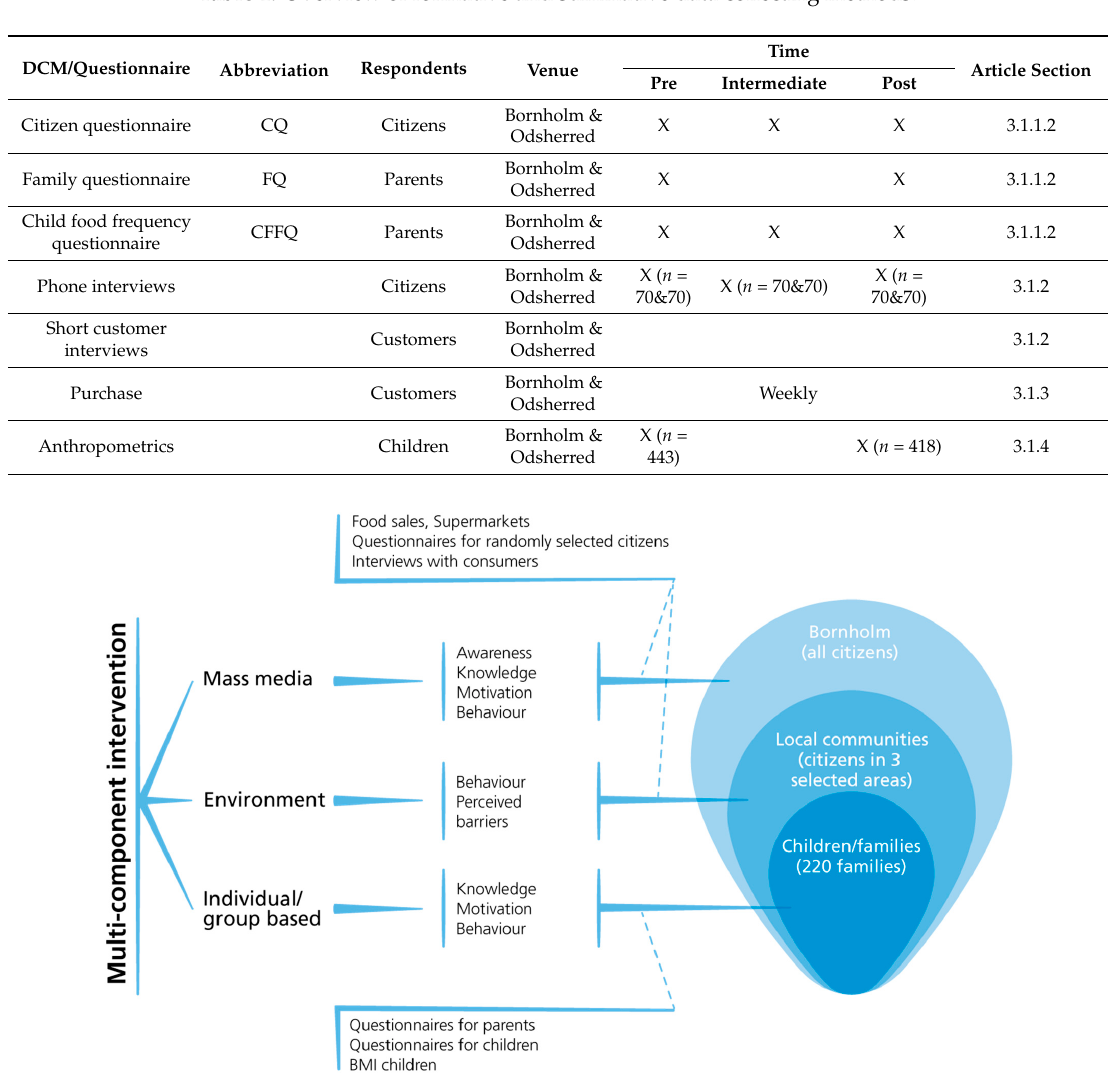
Figure 1. Conceptual model for the summative evaluation of the SoL intervention.